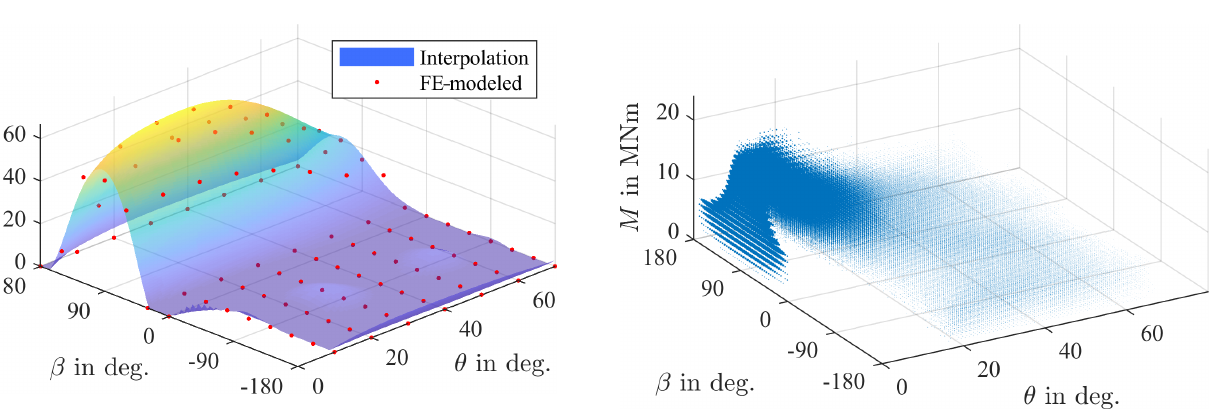
Figure 9. Dots for each chosen class occurring during aeroelastic simulations, with size relative to frequency of